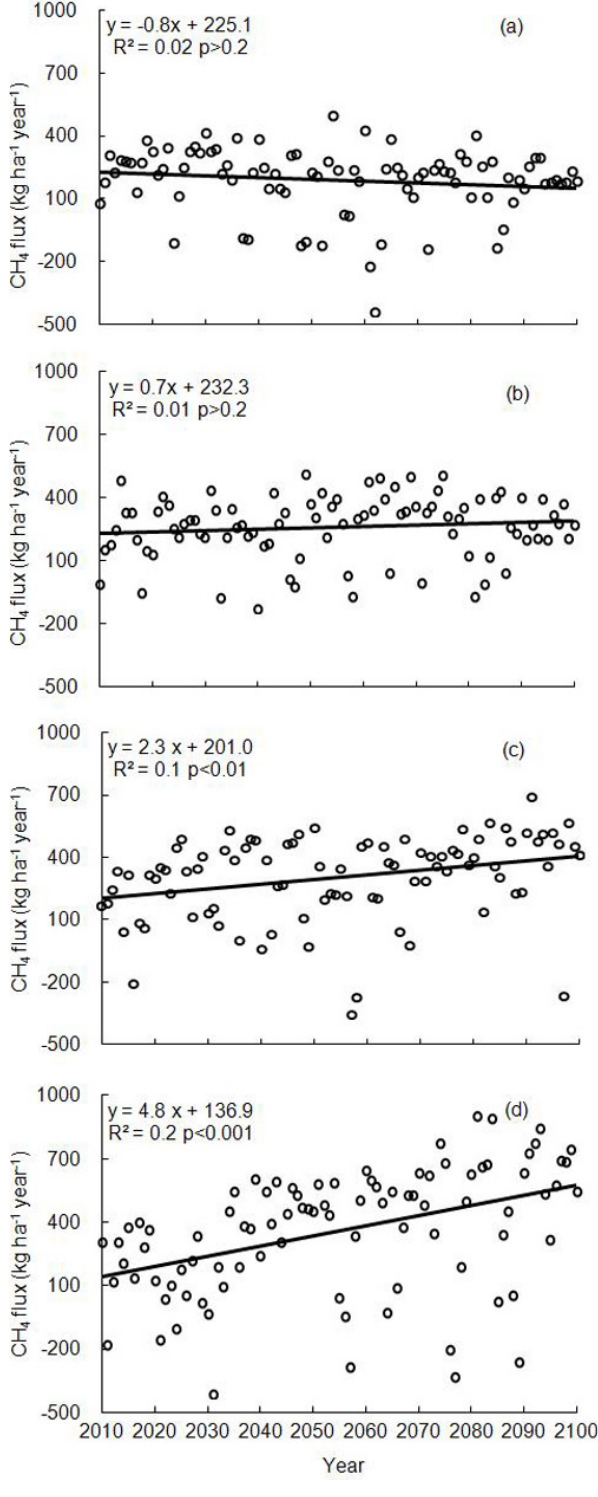
Fig. 6. Projected change of CH 4 fluxes relative to 1961–1990 on the Sanjiang Plain for RCP 2.6 (a) , RCP 4.5 (b) , RCP 6.0 (c) and RCP 8.5 (d)